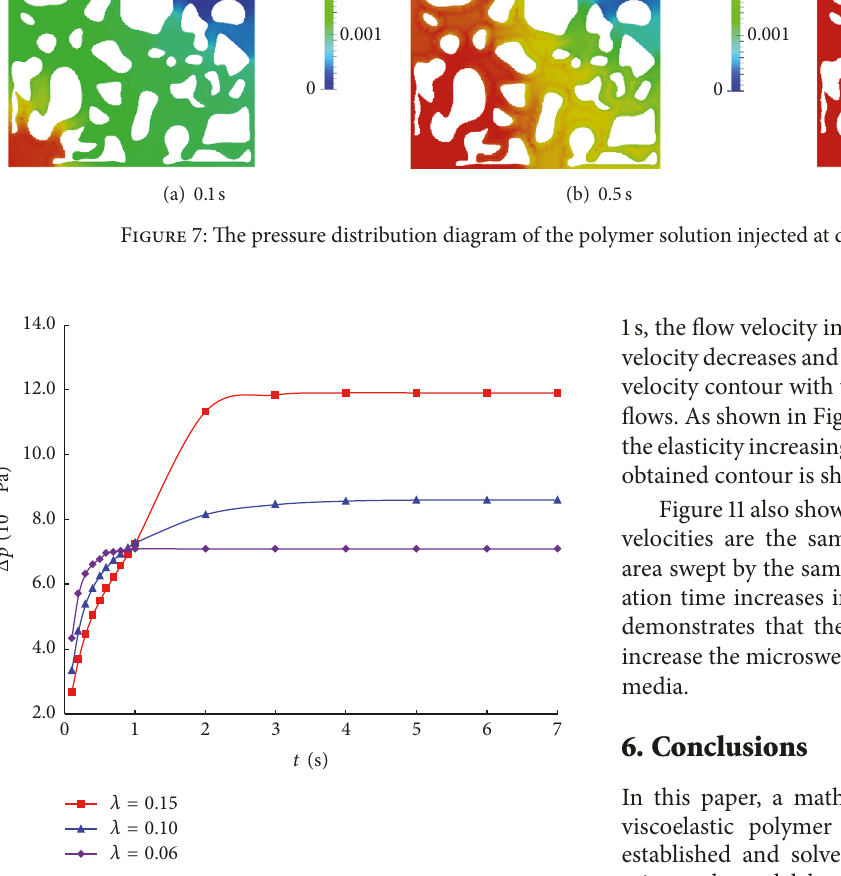
Figure 8: Pressure difference versus flow time at different relaxation